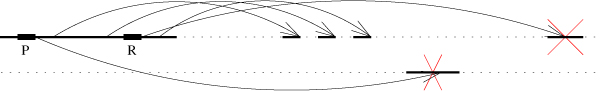
Repeats and palindromes. Repeats (R) and palindromes (P) can generate contigs with misleading positional information.